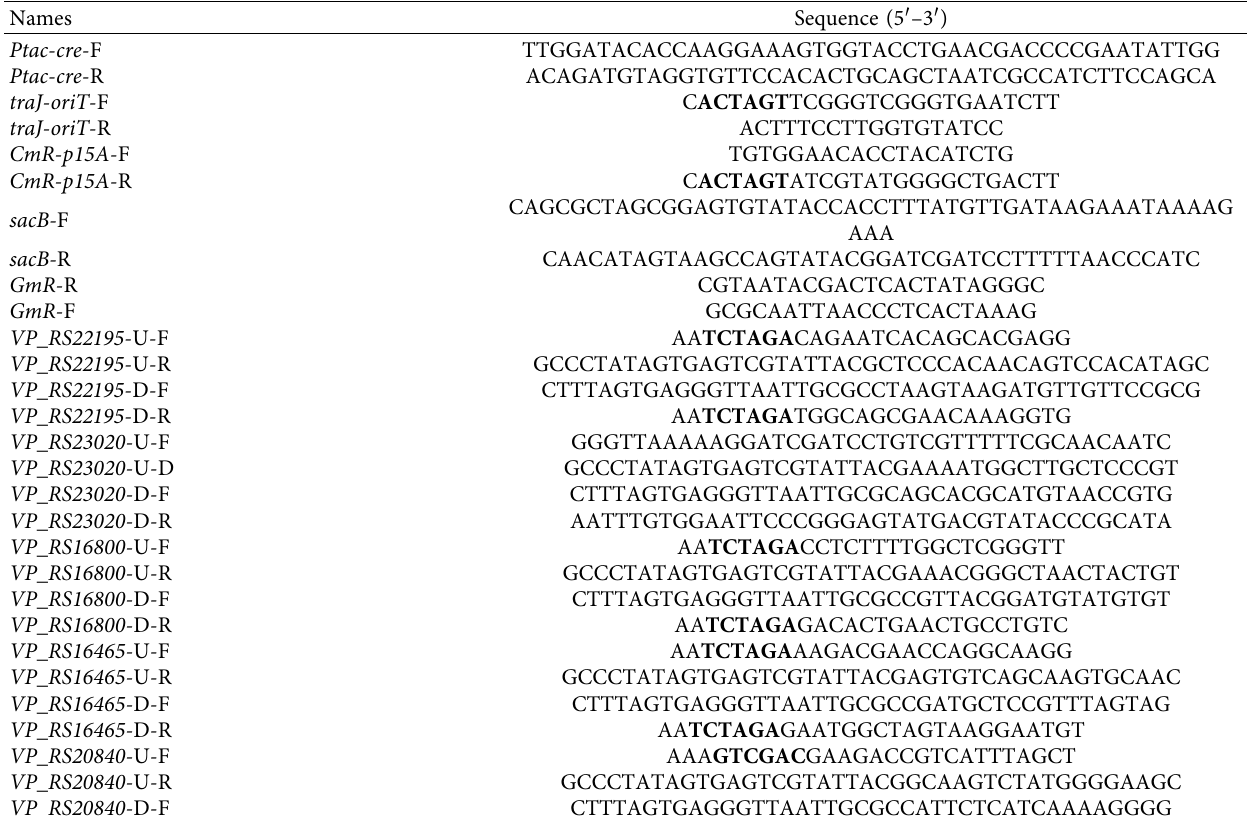
Table 2: Primers used in this